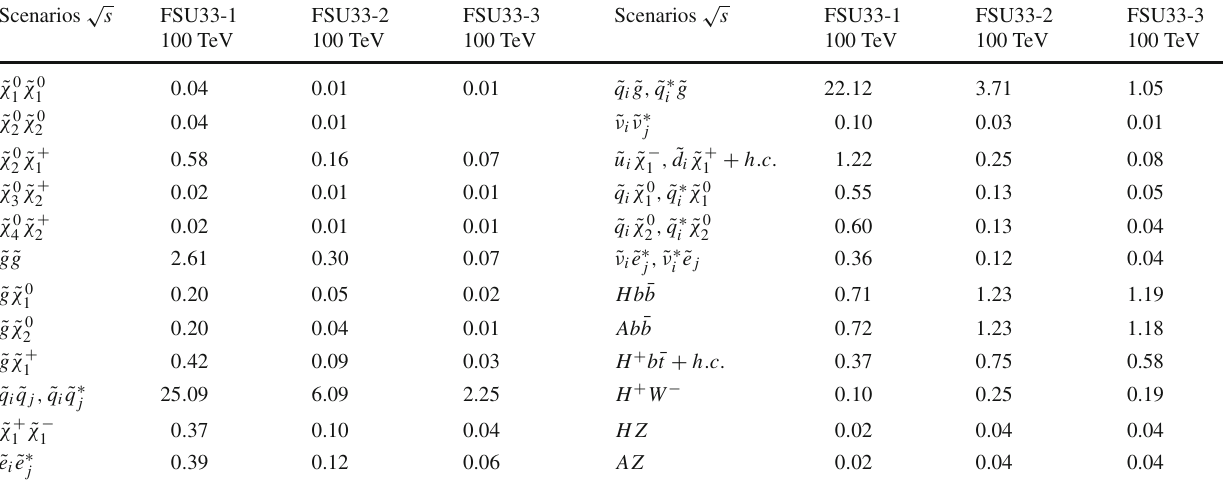
Table 9 Expected production cross sections (in fb) for SUSY particles in the FSU33 scenarios √ Scenarios